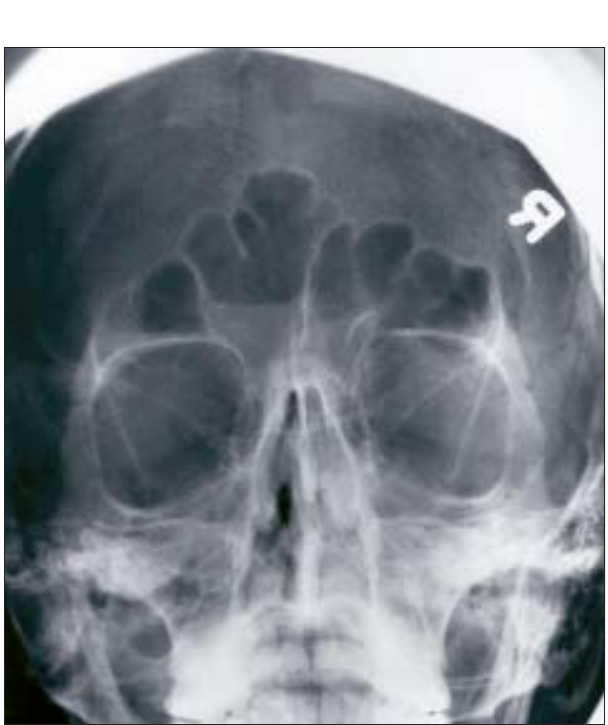
Figure 2) One view of the series of sinus radiographs taken at